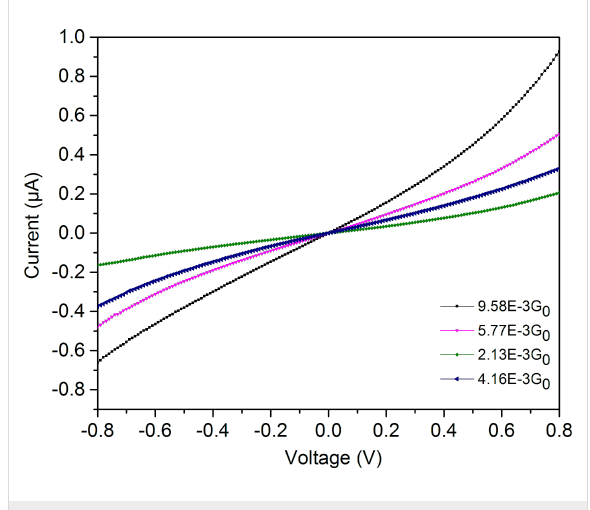
Figure 8: I – V -curves for the M2 molecule at the conductance values indicated (measured close to 0 V) at room temperature.